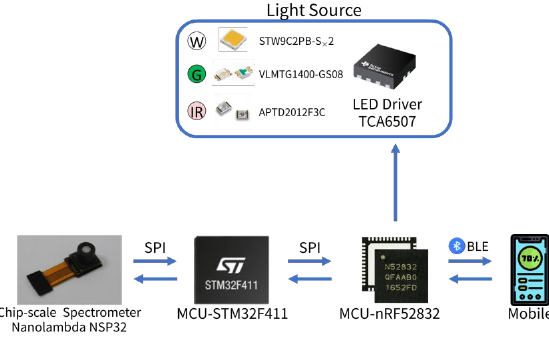
Figure 3. The proposed AW-PPG architecture.